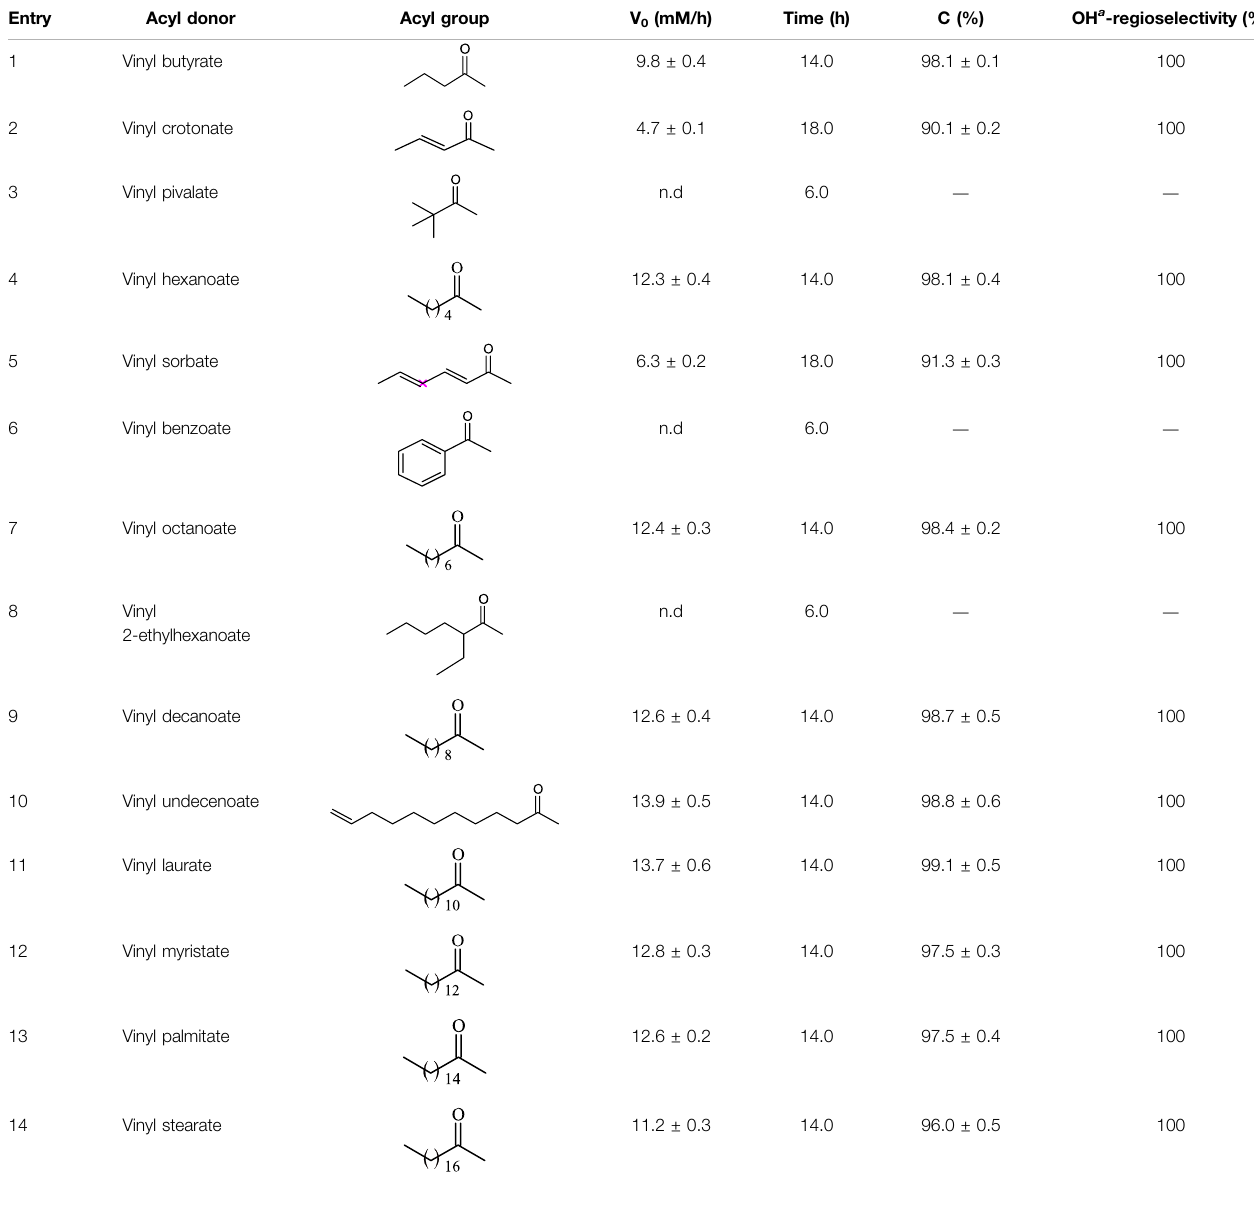
TABLE 3 | Effect of acyl donor structure on the acylation of polydatin catalyzed by Fe 3 O 4